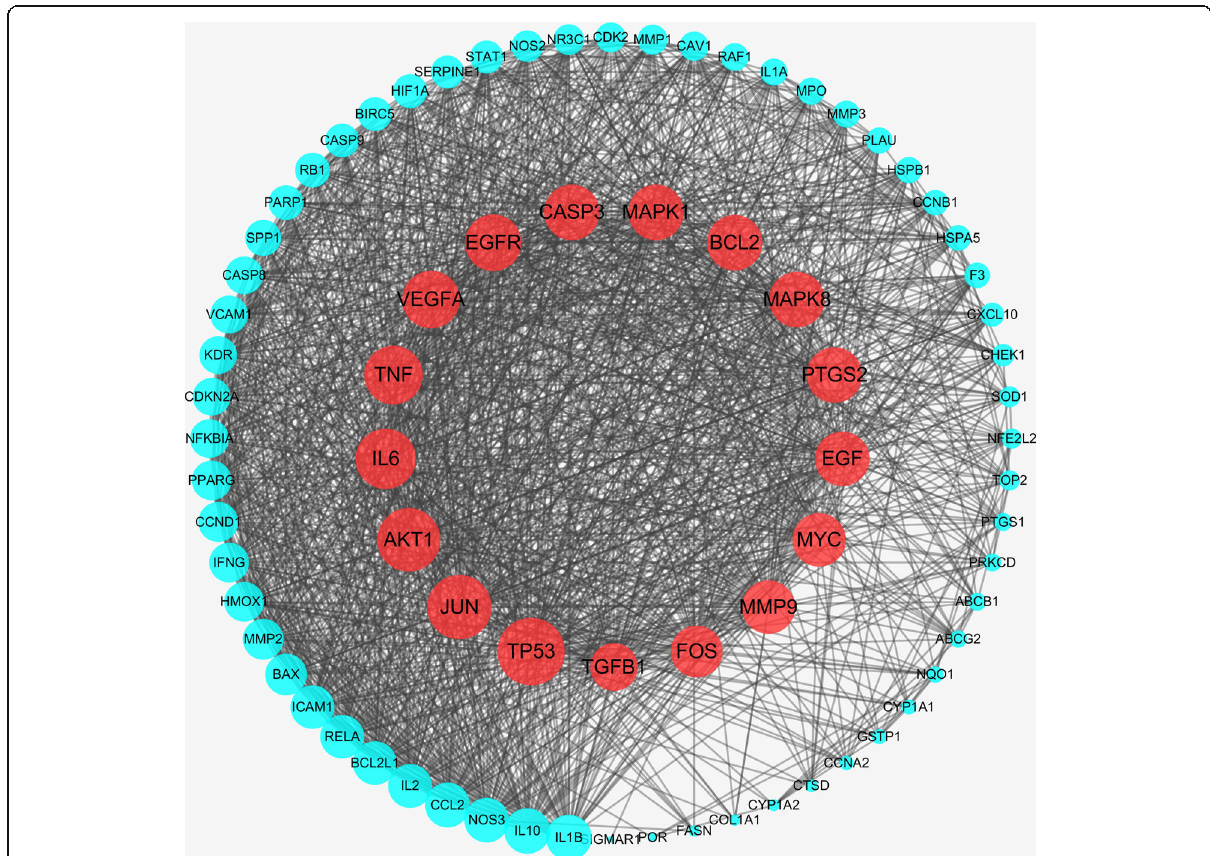
Fig. 5 The PPI network of 77 nodes. The red nodes represent the big hub nodes, the blue nodes represent the other nodes. The node size is proportional to the target degree in the